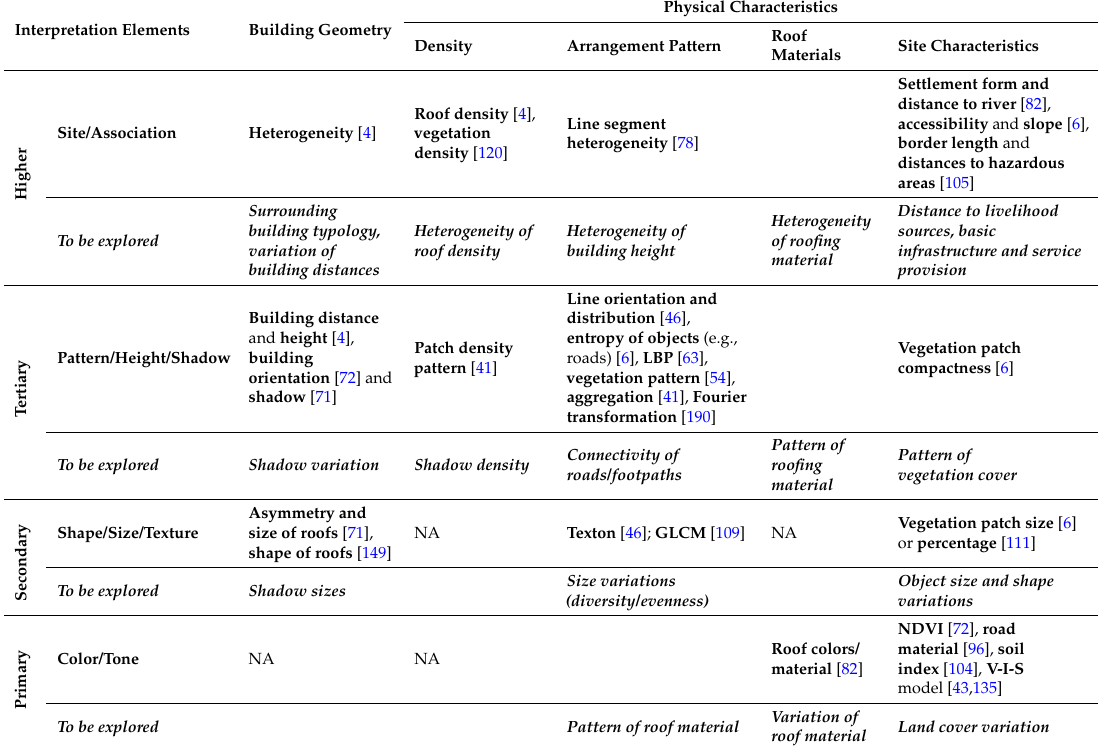
Table 8. Overview of successfully documented image-based proxies